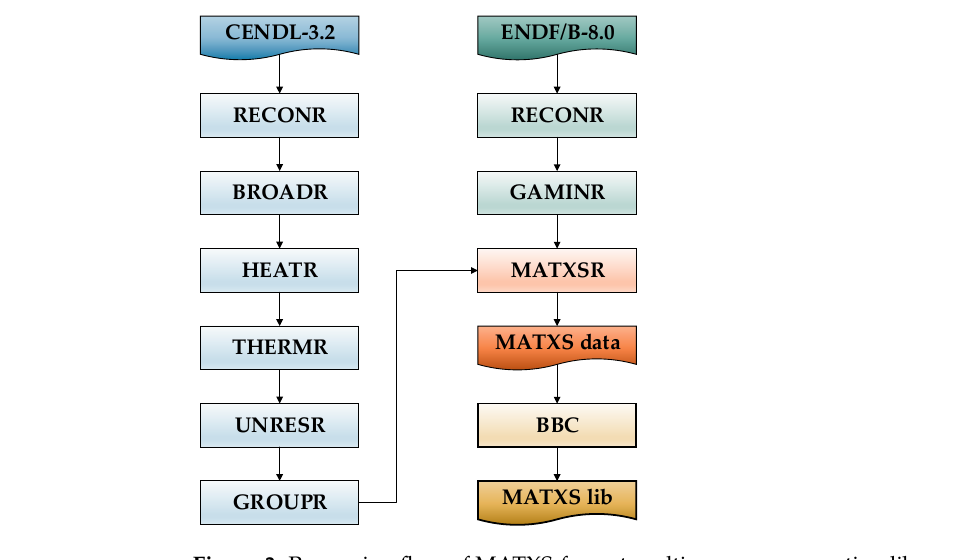
( b ) Figure 5. Geometry of ippe_fe iron sphere benchmark of shells and reentrant holes with various radii. ( a ) Simpli fi ed geometry of experimental device Shell 1, r = 2.0 cm, R = 4.5 cm. ( b ) Simpli fi ed geometry of experimental devices Shell 2 to 5, r = 4.5, 2.0, 1.9, and 2.0 cm, R = 12.0, 12.0, 20.0, and 30.0 cm, respectively. Due to the background e ff ects, the measured values should be corrected and con- verted to neutron leakage. The leakage was then normalized to one source neutron using a correction calculation. Thus, the thickness of each shell could simply be calculated from the value of R subtracted by r, and the iron sphere geometry could be simpli fi ed as shown